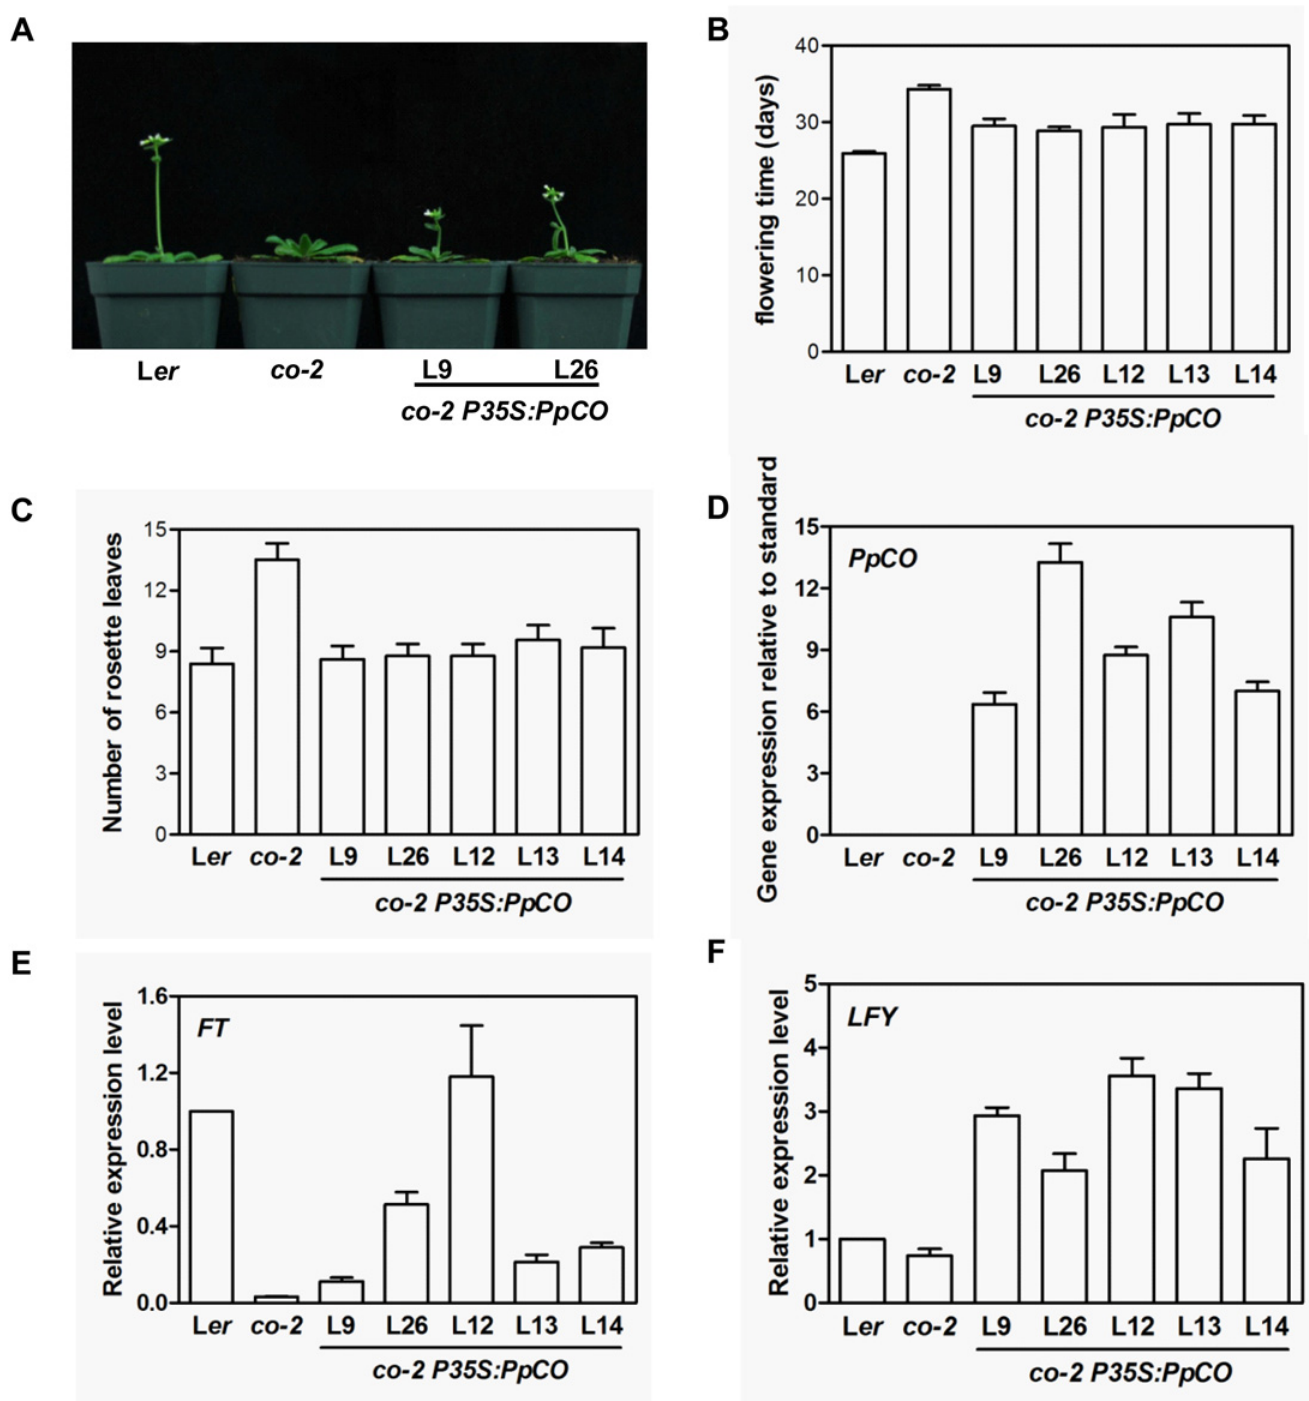
Fig 5. Phenotypes of co-2 P35S : PpCO transgenic plants. A. Flowering phenotypes of wild type (L er ), co mutant ( co-2 ) and co-2 P35S : PpCO lines. B. Statistics of average days at which the wild type (L er ), co mutant ( co-2 ) and transgenic lines started to bloom after sowing. C. Analysis of number of rosette leaves of different genotype plants at blooming. D. Real-time quantitative RT-PCR analysis of transcript accumulations of PpFT in different transgenic lines. The data were presented by calculating 2 - Δ Ct . The expressions of AtACTIN2 were used as controls. E-F. Real-time quantitative RT-PCR analysis of expression levels of FT (E) and LFY (F) in co-2 P35S : PpCO transgenic lines. The relative expression levels were first calculated by 2 - Δ Ct , and then divided by their relative expression levels in wild-type, and the ratios were presented. The expressions of AtACTIN2 were used as controls.